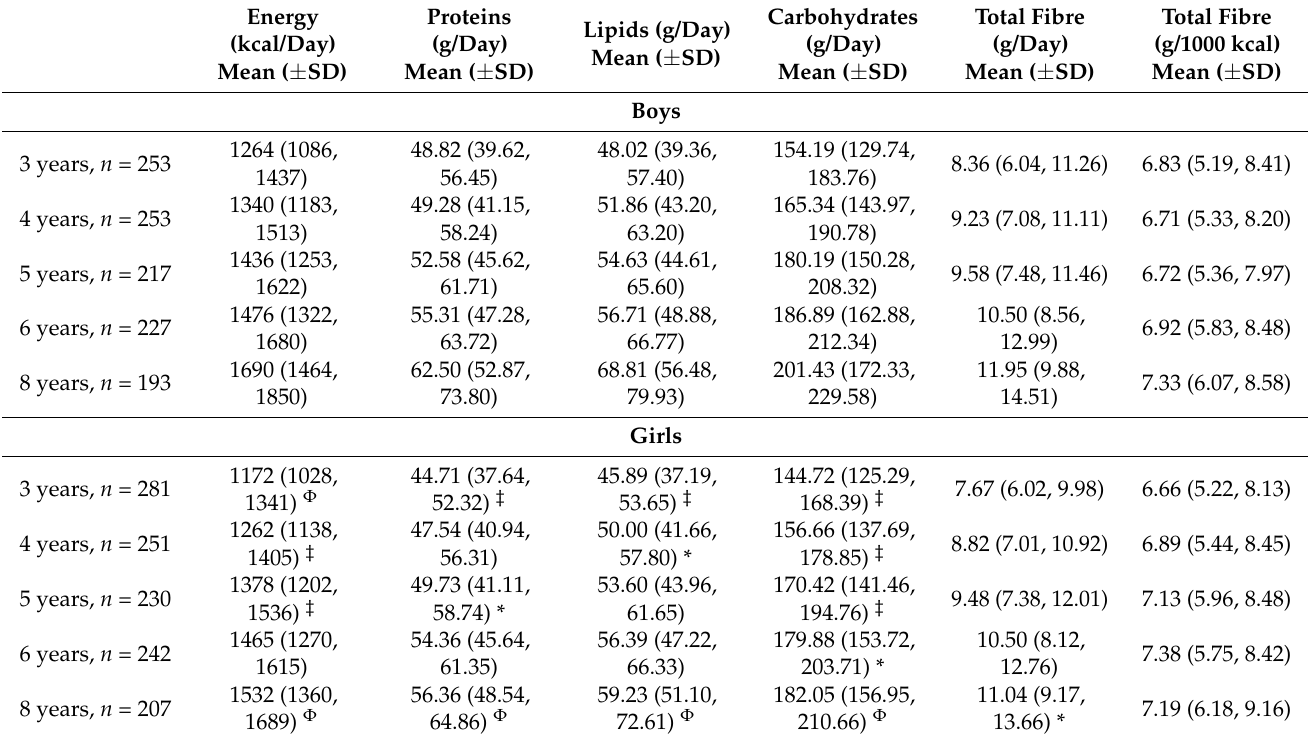
Table A1. Energy, macronutrient and fibre intake by age group and